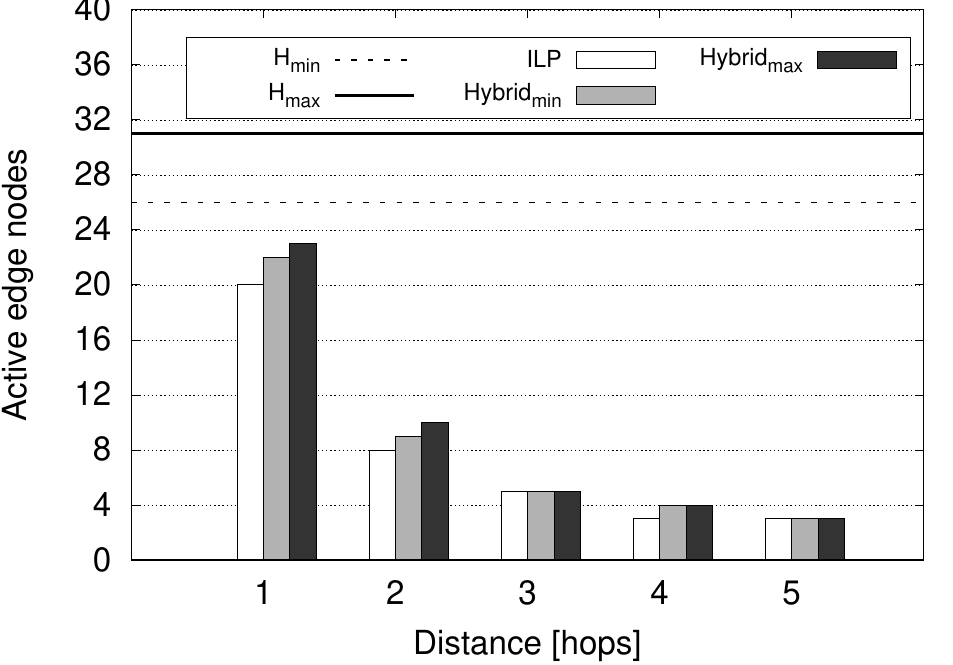
Figure 5. Total number of active edge nodes as a function of the allowed distance between RRUs and edge nodes for network N 38 : Maximum and minimum costs of the hybrid results are reported after both